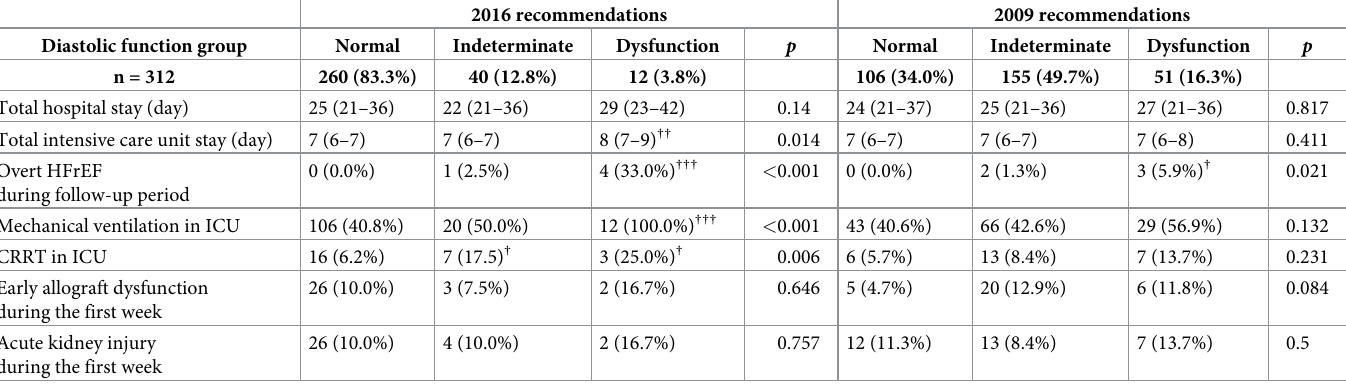
Table 5. Comparison of postoperative outcome between the normal diastolic, indeterminate, and diastolic dysfunction groups using the 2016 and 2009 recommen- dations in patients undergoing living-donor liver transplantation.